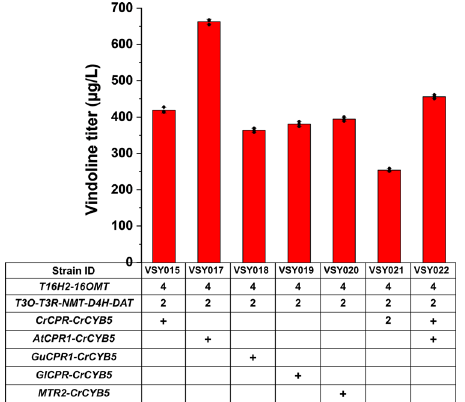
Fig. 4 Combinatorial optimization of CYPs-CPRs pairing to improve vindoline production. Five CPRs with different origins ( CrCPR from C. roseus , AtCPR1 from A. thaliana , GuCPR1 from G. uralensis , GlCPR from G. lucidum , and MTR2 from Medicago ) were integrated into the yeast genome and their effects on vindoline production were investigated. All strains were cultured in SC with 2% galactose in the presence of 50 mg/L tabersonine. Error bars represent SD of biological triplicates ( n = 3).